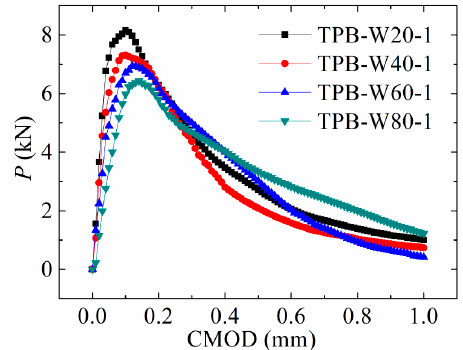
Figure 9. P- CMOD curves of the beams with different preset crack lengths.